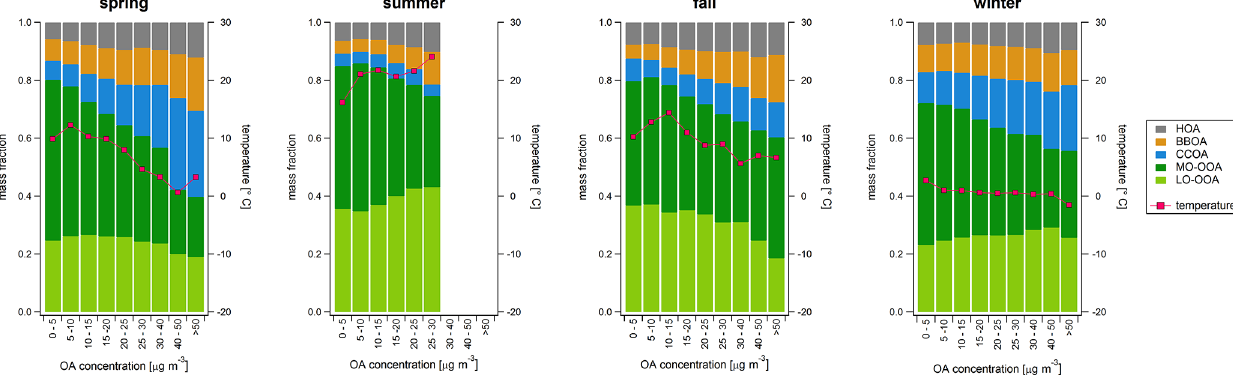
Figure 5. Seasonal contributions of the OA sources (HOA, BBOA, CCOA, MO-OOA and LO-OOA) as a function of the total submicron OA mass loadings. The average bin temperature is shown in